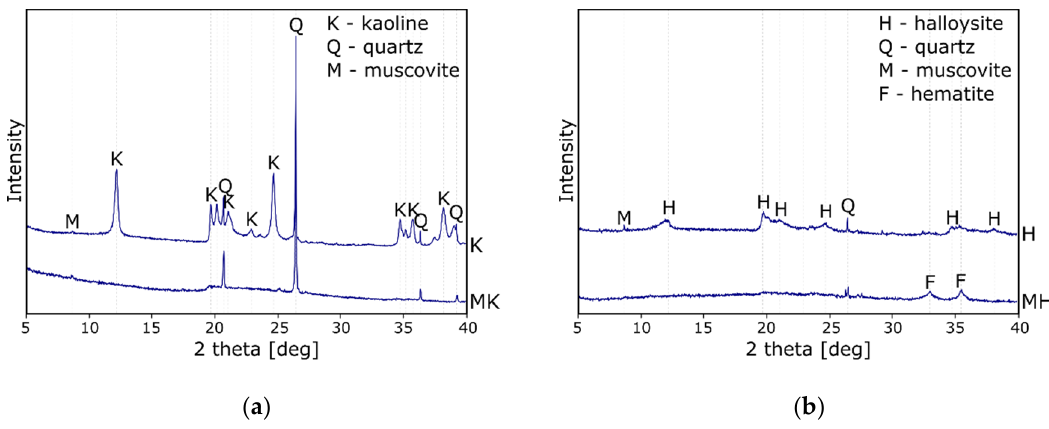
Figure 1. The X-ray diffractometry (XRD) patterns of initial clays and clays after the calcination at 700 °C: ( a ) kaolinite; ( b ) halloysite.